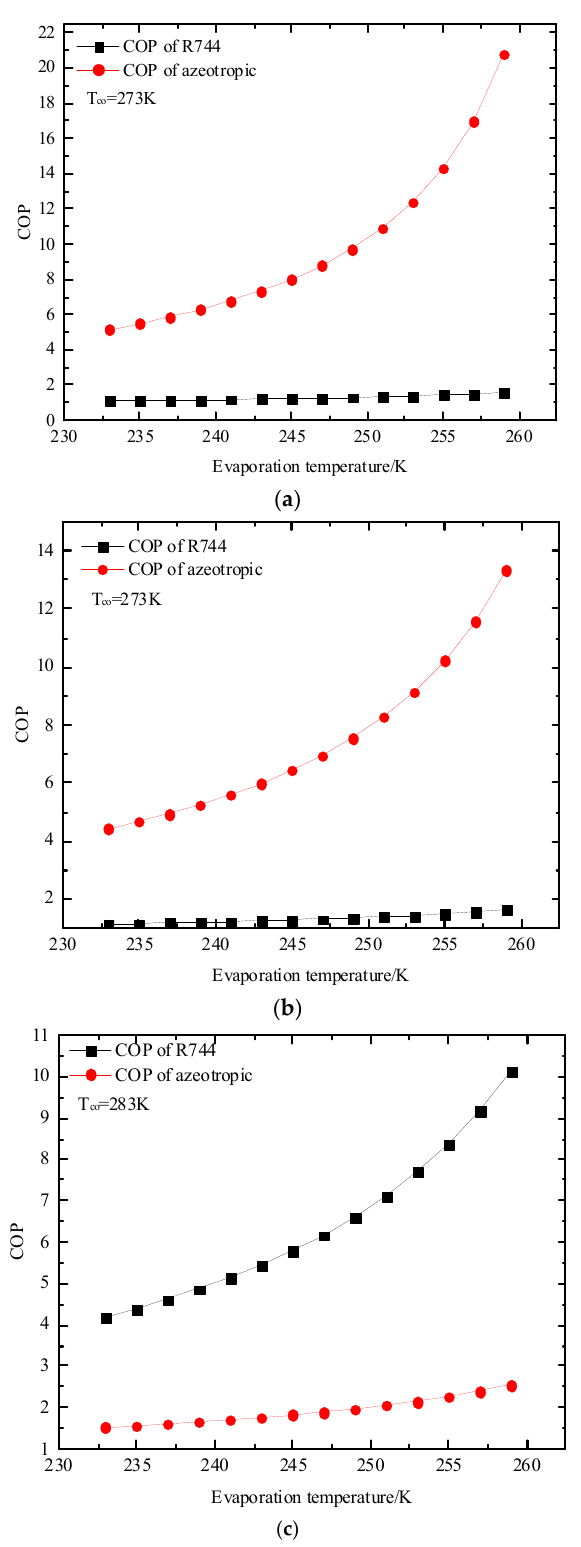
Figure 22. Comparison of COP values of azeotropic refrigerant and R744 varies with evapora- tion temperature at different outlet temperatures of condenser: ( a ) T co = 273 K; ( b ) T co = 278 K; ( c ) T co = 283